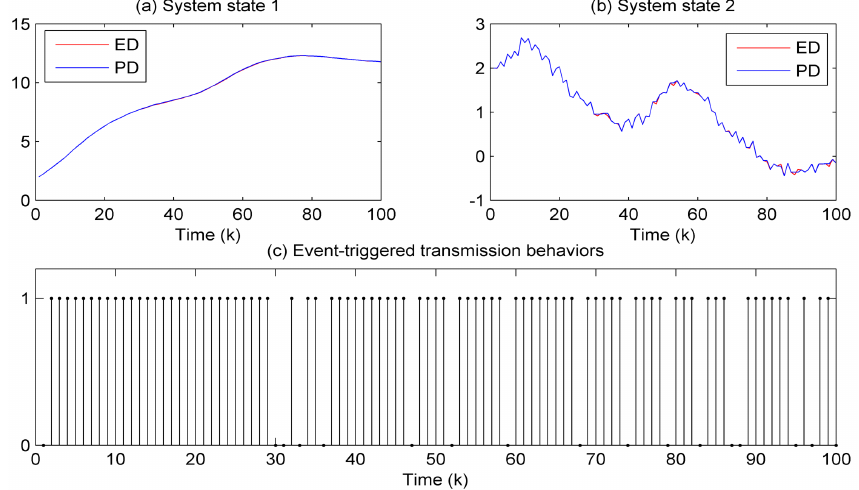
Figure 1. State estimation trajectories without fault f k and the corresponding event-triggered transmission